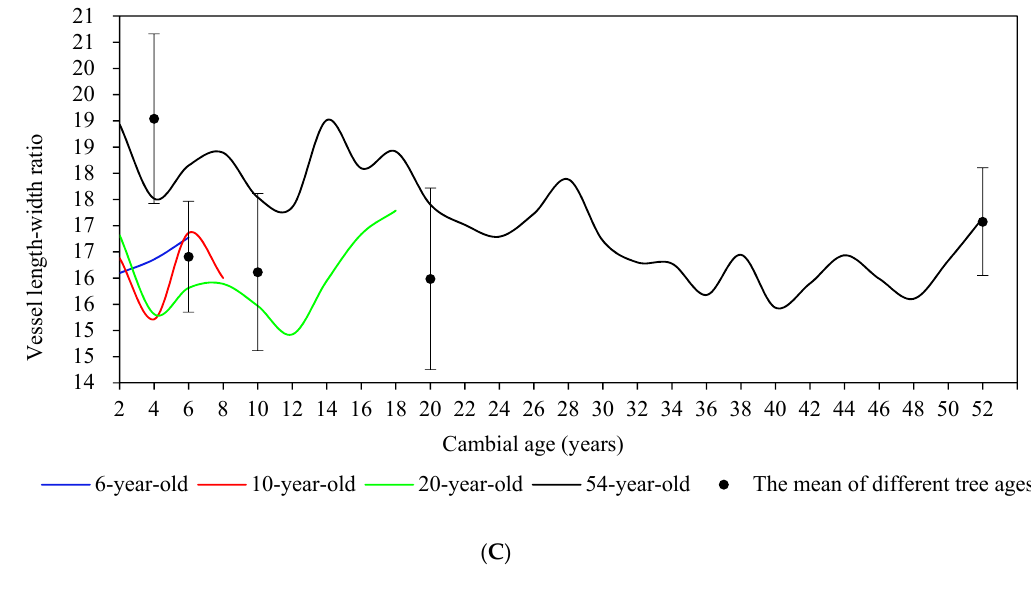
Figure 8. The radial variation of vessel wall-lumen ratio ( A ), vessel lumen-width ratio ( B ) and vessel length-width ratio ( C ) versus cambial age and the mean of differently aged S. superba.